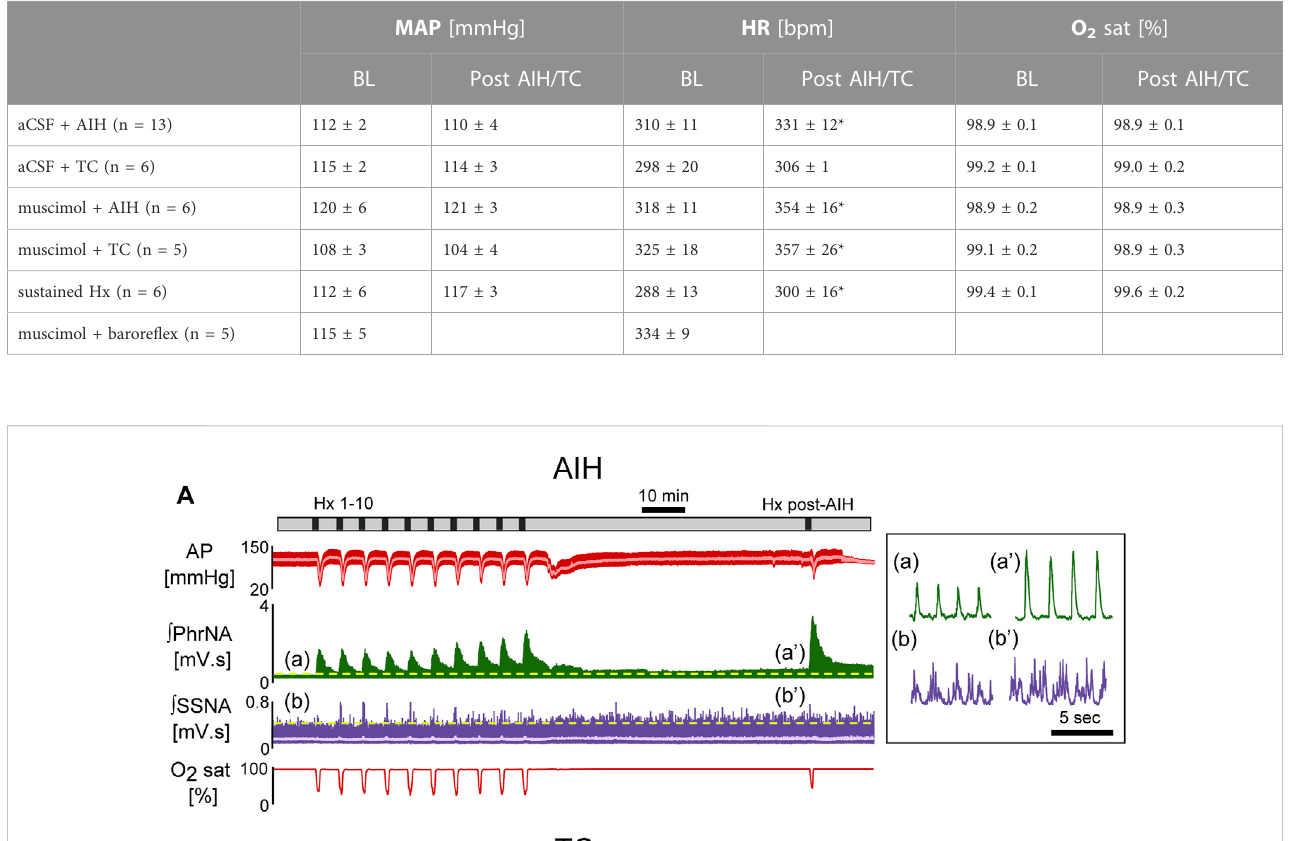
TABLE 1 Mean arterial pressure (MAP), heart rate (HR) and arterial oxygen saturation (O 2 sat) at baseline (BL, left) prior to any experimental manipulations and 1 h followingAIH or TC (right) of experimental groups used in this study. There were no statistical differences among groups at BL (One-way ANOVA).Also,comparison of hemodynamic parameters over the course of the experiment (Post AIH/TC) indicate no difference in MAP or O 2 saturation. However, HR increased in most groups followingeitherAIHorTC.Paired t -test: p ≤ 0.05:*1 hpost-AIHorpost-TCvs.BL.Animalsthatwereanalyzedforbarore fl exfunctionwerenotsubjectedtohypoxiaand O 2 saturation was not monitored.